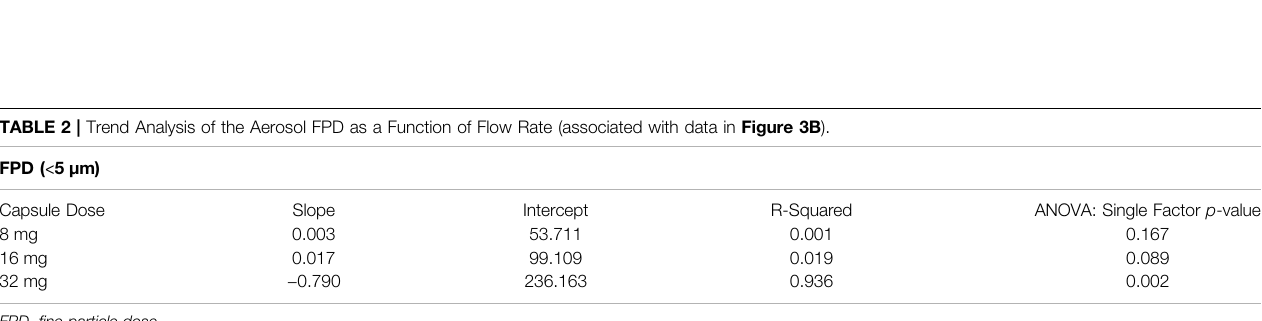
197 – 200 µg for the 32 mg capsule dose; however, for the MR and LR devices the FPD decreased to 168 and 155 μ g, respectively ( Figure 3C ). The statistical analysis of the